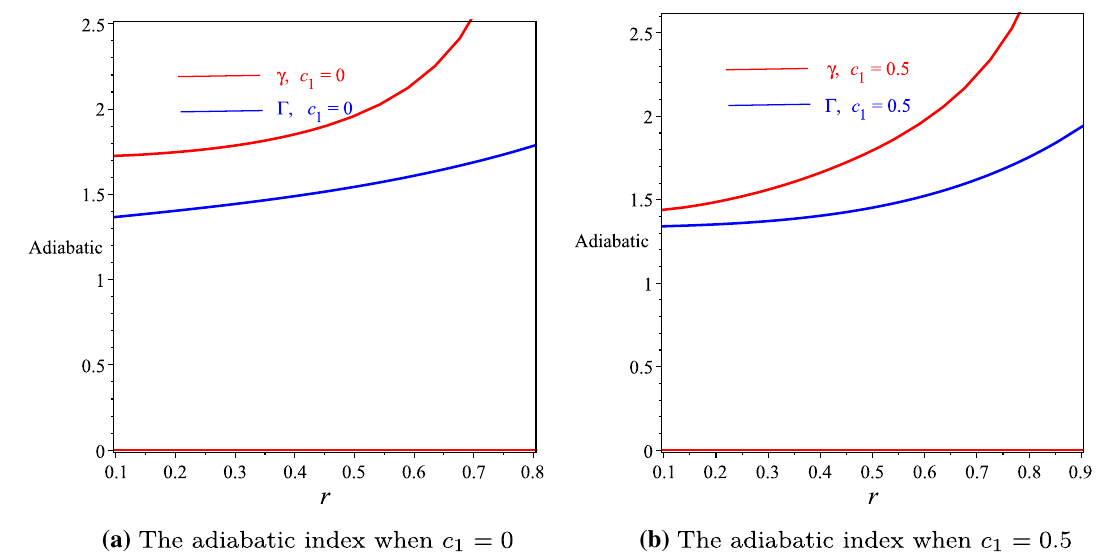
Fig. 10 The adiabatic index of solution given in Appendix A for c 1 = 0 and c 1 = 0 . 5 Table 1 The boundary density ρ l and slope of the radial pressure reported for various observed objects. The density and the derivative of radial pressure are derived for the values c 1 = 0 and c 1 = 0 . 5 at the stellar boundary l assuming a nuclear density of the order 10 15 g / cm 3